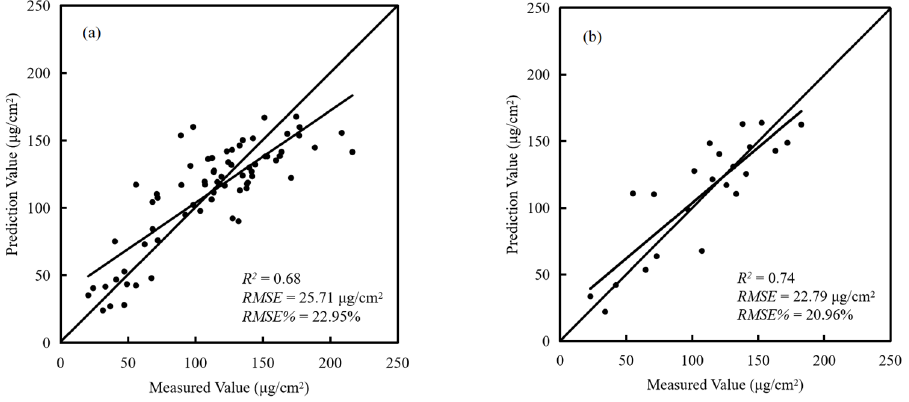
Figure 5. PLSR model results. ( a ) Calibration; ( b ) Validation.